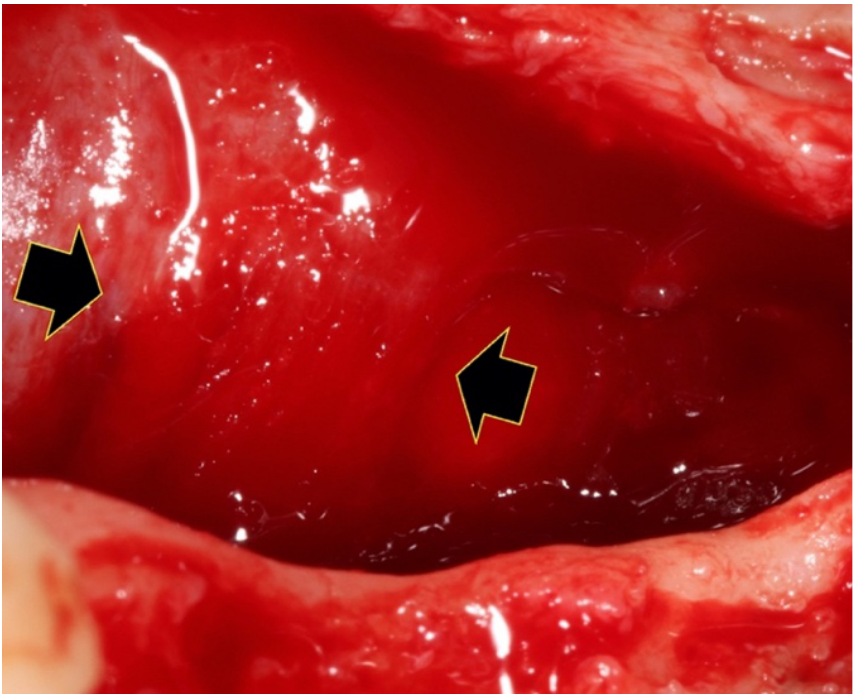
Figure 9. Clinical overview of the connective tissue band of 1–2 cm at the area of the first molar (black arrows), where the mylohyoid muscle attaches to the lingual flap.